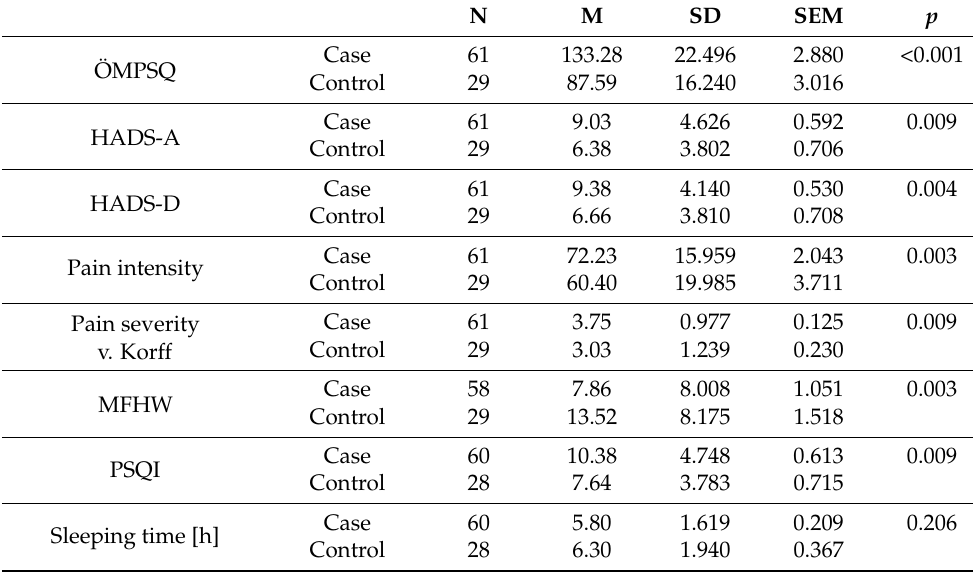
Table 2. Questionnaire scores in case and control group.